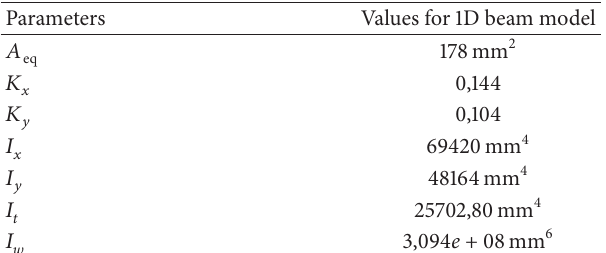
Table 2: Equivalent beam properties estimated by the dynamic FE- based